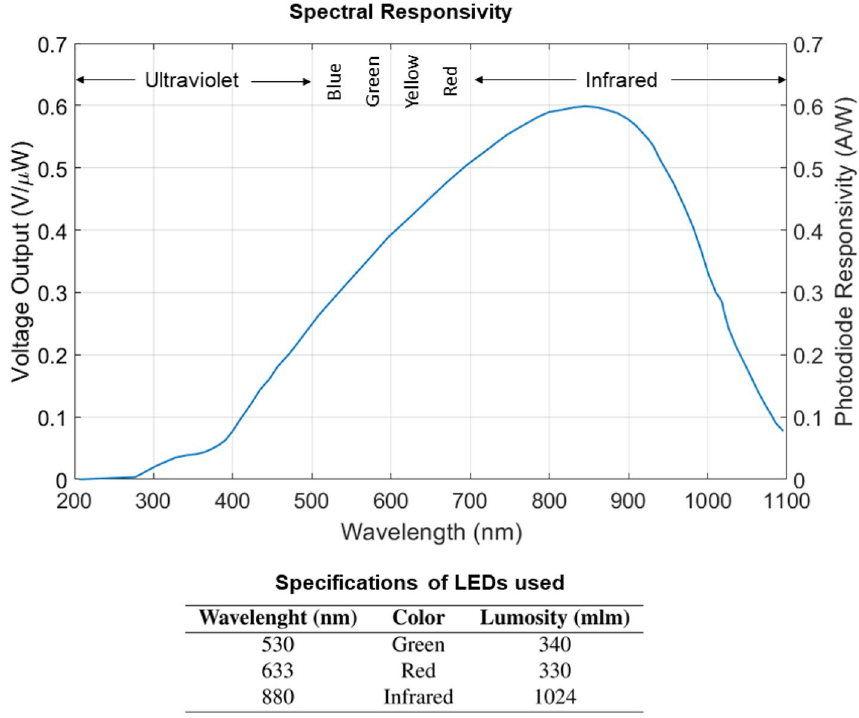
Figure 3. Characteristics of the analyzed LEDs and photodiode 34 .